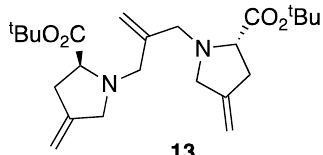
Figure 2. Structure of byproduct 13.